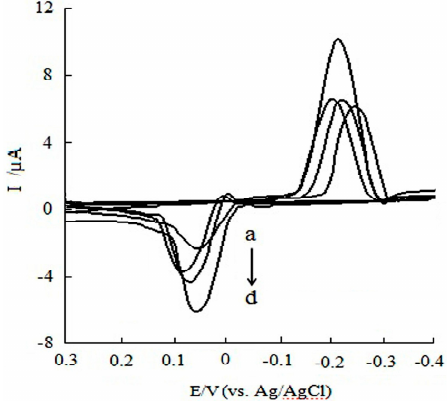
Figure 4. Cyclic voltammetry curves of CGA ( a ) at bare SPE and ( b ) at MWCNTs/SPE.